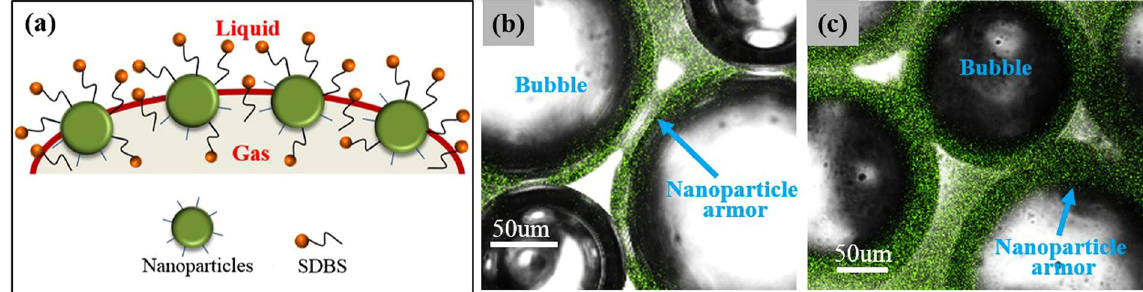
Figure 8. ( a ) Illustration of nanoparticle-surfactant interaction and nanoparticle adsorption on bubble surface. Confocal fluorescence image of SiO 2 /SDBS foams: ( b ) 0.25 wt% SiO 2 nanoparticle + 0.1 wt% SDBS + N 2 ; ( c